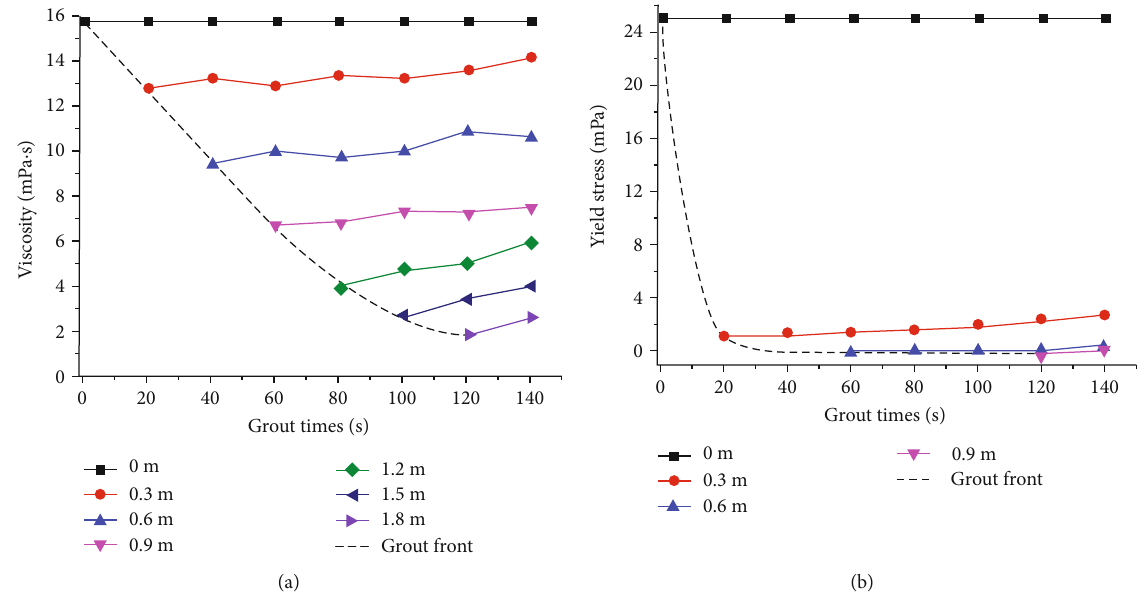
Figure 5: The temporal and spatial variation in slurry viscosity and yield stress in no.7 test ((a) the variation of slurry viscosity; (b) the variation of slurry yield stress).